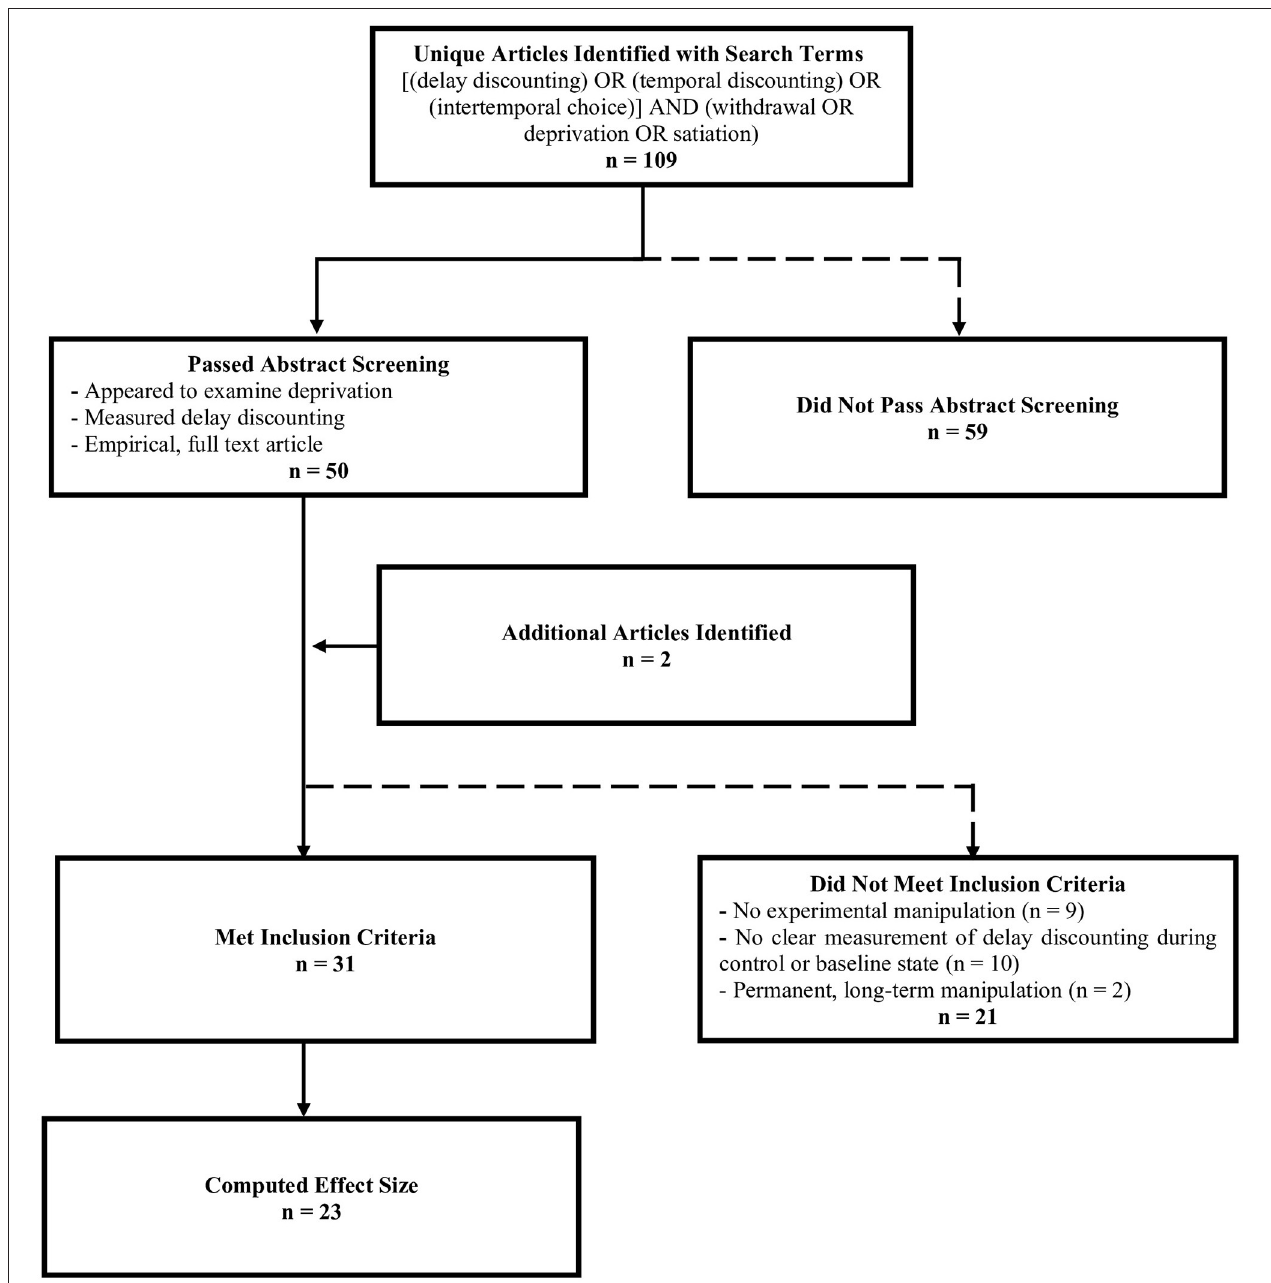
FIGURE 1 | Number of articles included at each stage of the screening process. Dashed lines indicate points at which articles were